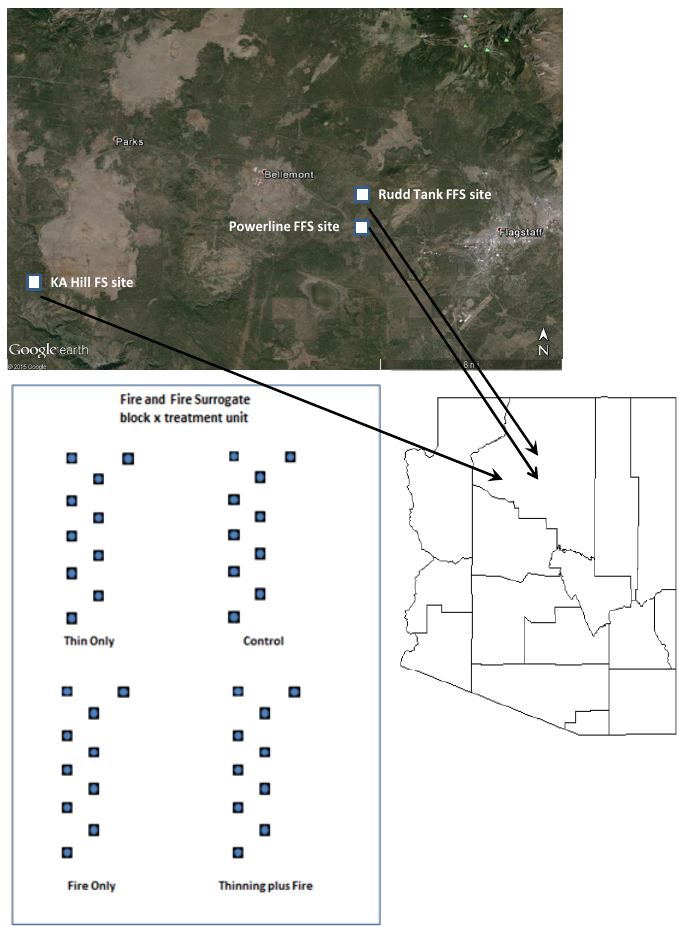
Figure 1. Southwest Plateau Fire and Fire Surrogate block locations and a generalized treatment plot design. Each of four 10-ha core treatment units are within each replicate block. Each treatment unit has 36 (typically 6 ˆ 6) permanent gridpoints located 50 m apart oriented north to south. The small squares shown within each treatment unit are soil subplots (20 ˆ 50 m) located adjacent to every other permanent gridpoint for up to ten soil subplots. Each soil subplot’s southeast corner is 10 m east of each permanent